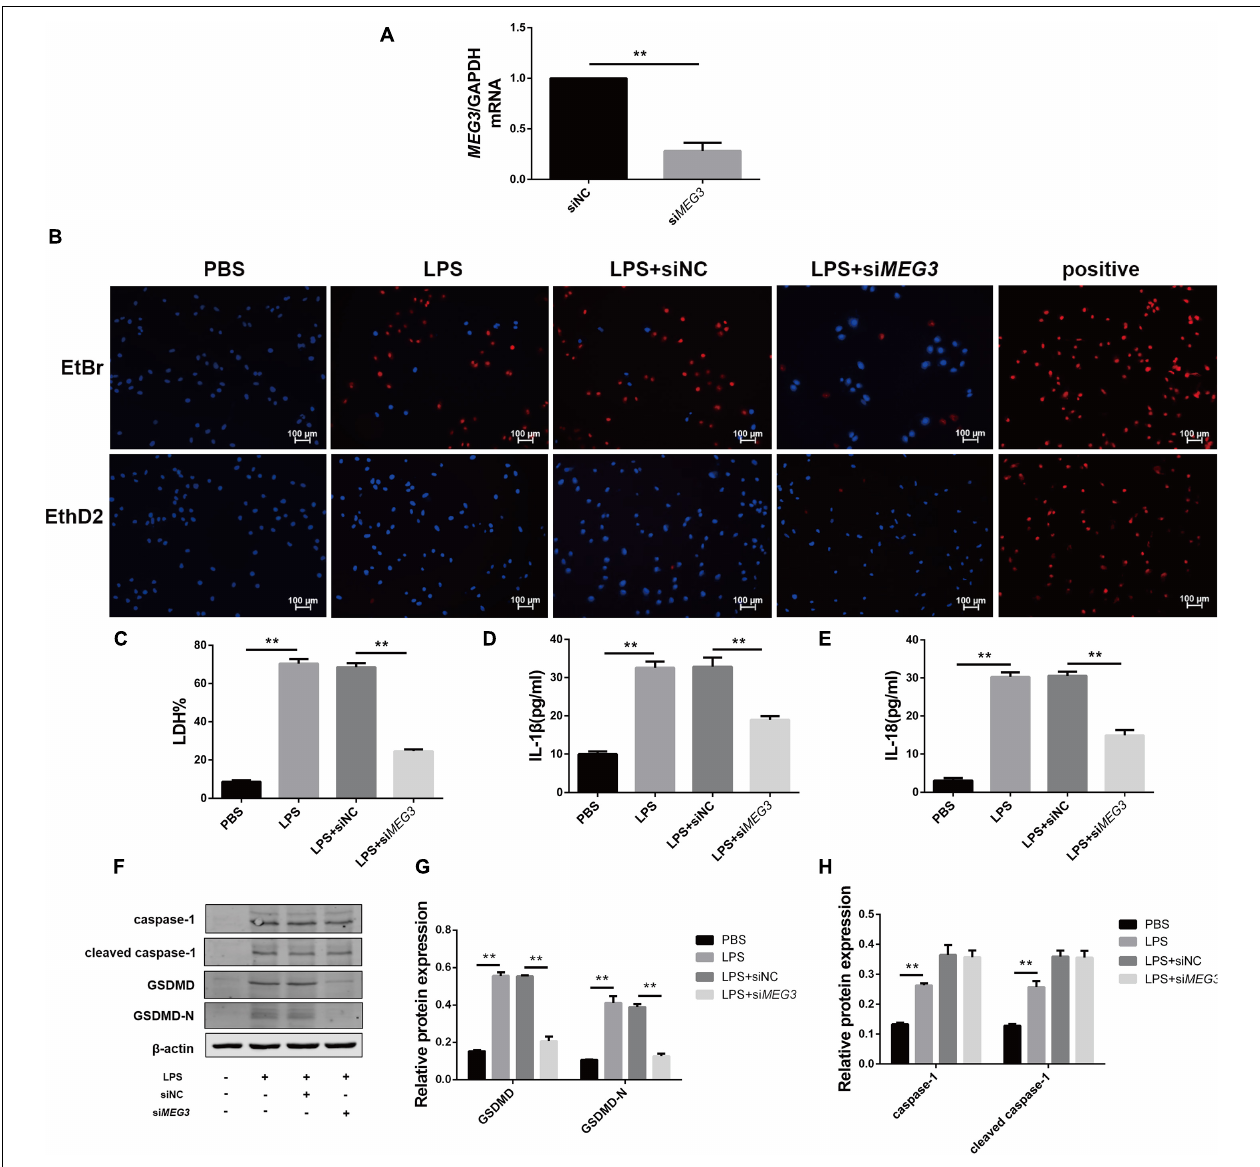
FIGURE 3 | Knockdown of MEG3 in TECs inhibited LPS-induced pyroptosis. (A) MEG3 mRNA levels transfected with siRNA. (B) siRNA-transfected TECs stained with EtBr and EthD2. (C) LDH% in supernatants obtained from siRNA-transfected TECs. (D–G) Release of IL-1 β and IL-18 in supernatants obtained from siRNA-transfected TECs. (F–H) Protein expression of caspase-1, cleaved caspase-1, GSDMD, and GSDMD-N in siRNA-transfected TECs. ** P < 0.01, compared with the respective control